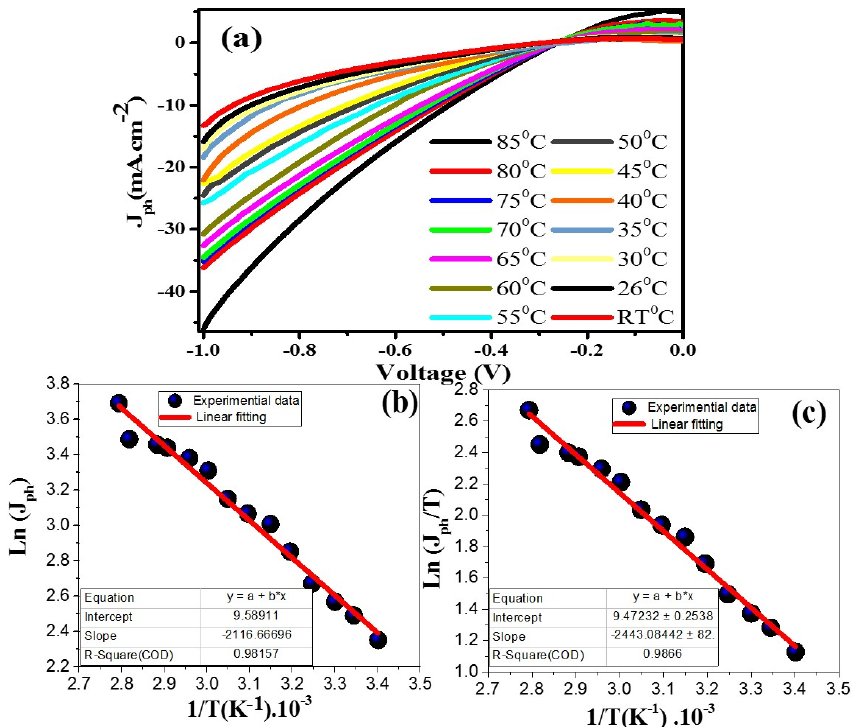
Figure 8. Effect of temperature: ( a ) the J ph -voltage plots at temperatures in the range from RT to 85 °C, ( b ) ln( J ph ) and (1/T) plots, and ( c ) Ln ( J ph /T) and (1/T)